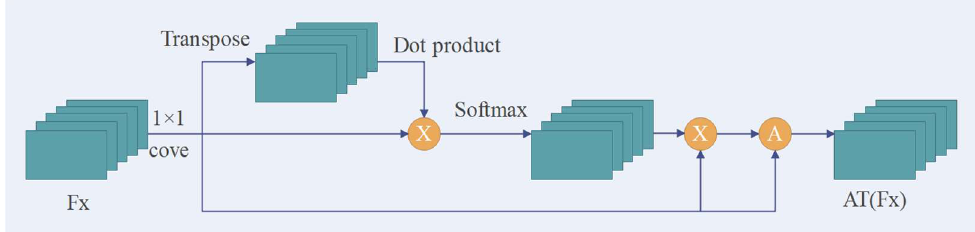
Figure 5. Attention model feature enhancement module.